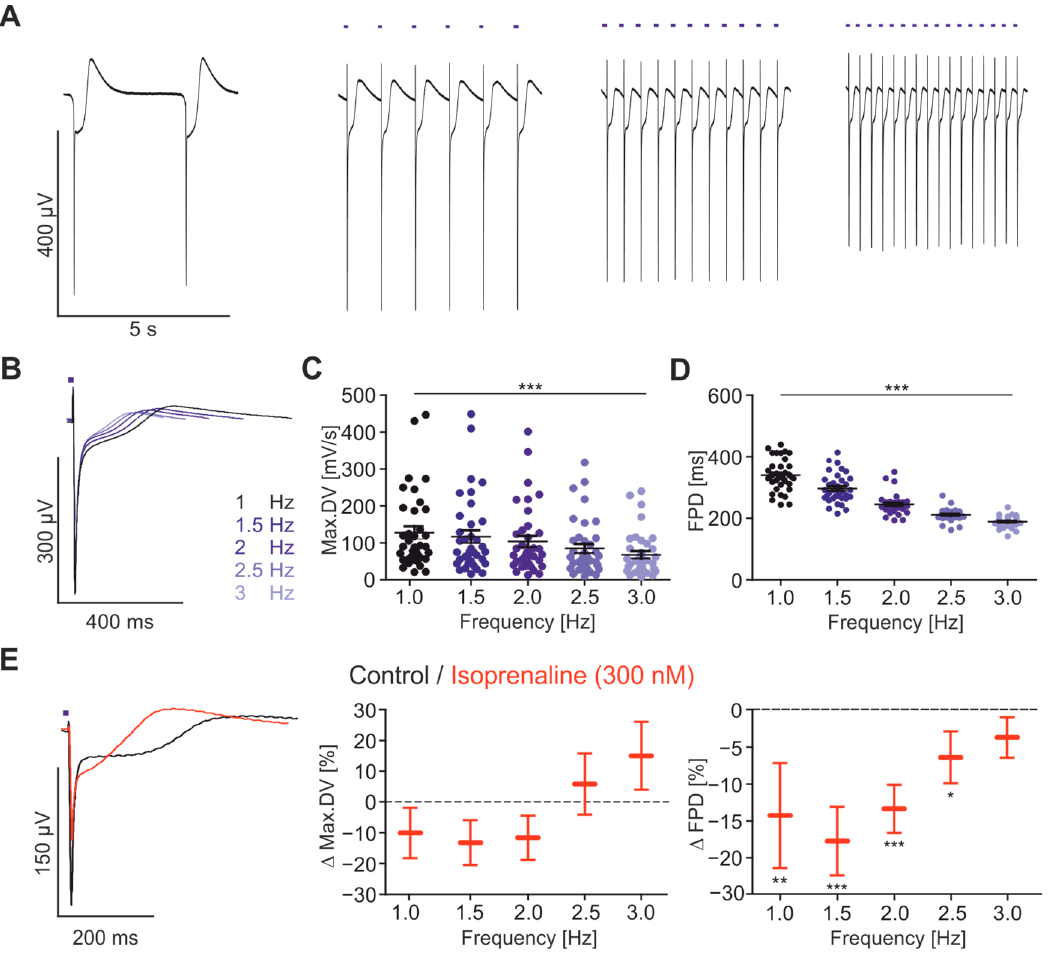
Figure 3. Optogenetically paced FP at various physiological stimulation rates. ( A ) Representative FP traces during (from left to right) spontaneous beating and optical pacing (blue bars) at 1 Hz, 2 Hz and 3 Hz; ( B ) overlay of representative FP paced at frequencies 1–3 Hz (from black to light blue); ( C ) statistical analysis of absolute values of max.DV (from 1 to 3 Hz: − 47 ± 14%, p < 0.0001, n = 37) and ( D ) FPD (from 1 to 3 Hz: − 43 ± 1%, p < 0.0001, n = 42); ( E ) Representative FP before and after application of 300 nM Isoprenaline and relative changes of max.DV ( middle ) and FPD ( right ) ( n = 24). * p < 0.05, ** p < 0.01, *** p < 0.001.